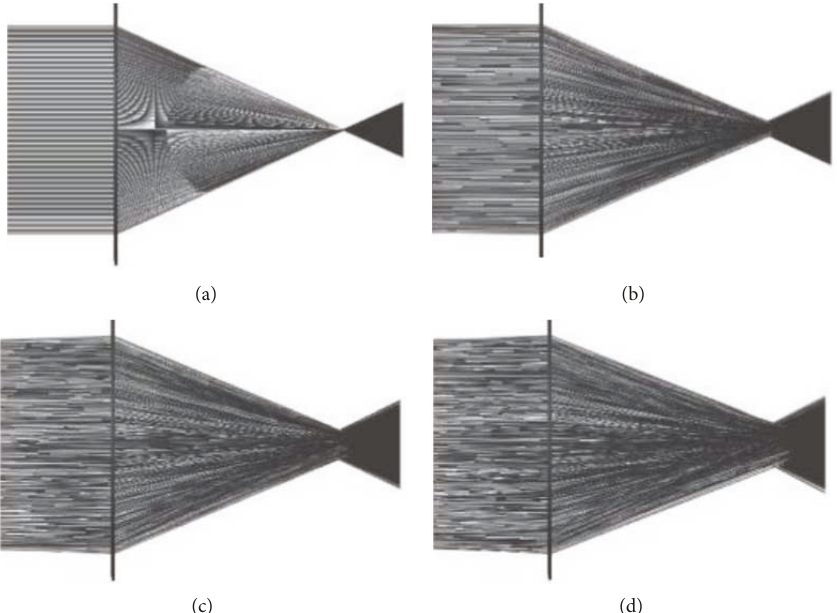
Figure 5: The diagram of the result of a 500nm monochromatic incident light with di ff erent divergence angles concentrated by a lens. (a) Divergence angle at 0 ° . (b) Divergence angle at 1 ° . (c) Divergence angle at 2 ° . (d) Divergence angle at 3 °